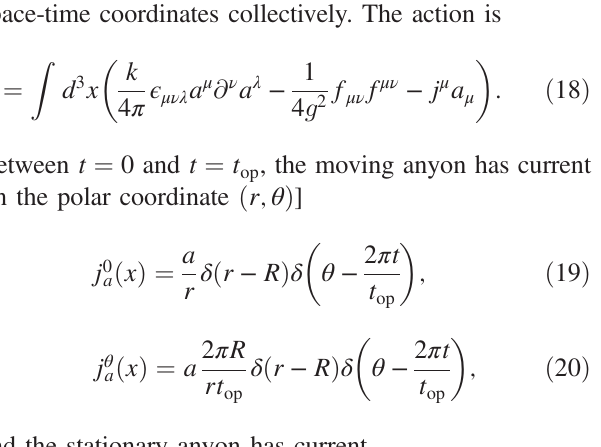
FIG. 3. The deviation of the density matrix after projection onto the ground state, ∥ ρ by the total evolution time, Δ t as in Fig.